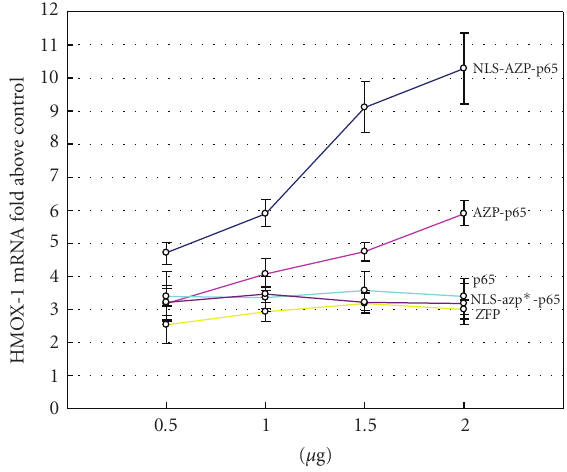
Figure 6: E ff ect of the ATF on endogenous HMOX1 expression. Quantitative real-time RT-PCR was performed; the candidate vectors were pcDNA3.1-AZP-p65-flag (AZP-p65), pcDNA3.1-NLS- AZP-p65-flag (NLS-AZP-p65), PUC57-AZP (AZP), pcDNA3.1- NLS-eGFP-p65-flag (p65), and pcDNA3.1-NLS-azp ∗ -p65-flag (NLS-azp ∗ -p65). For each of them, four dose gradients (0.5 μ g, 1.0 μ g, 1.5 μ g, and 2.0 μ g) were used. The data represent the means ±